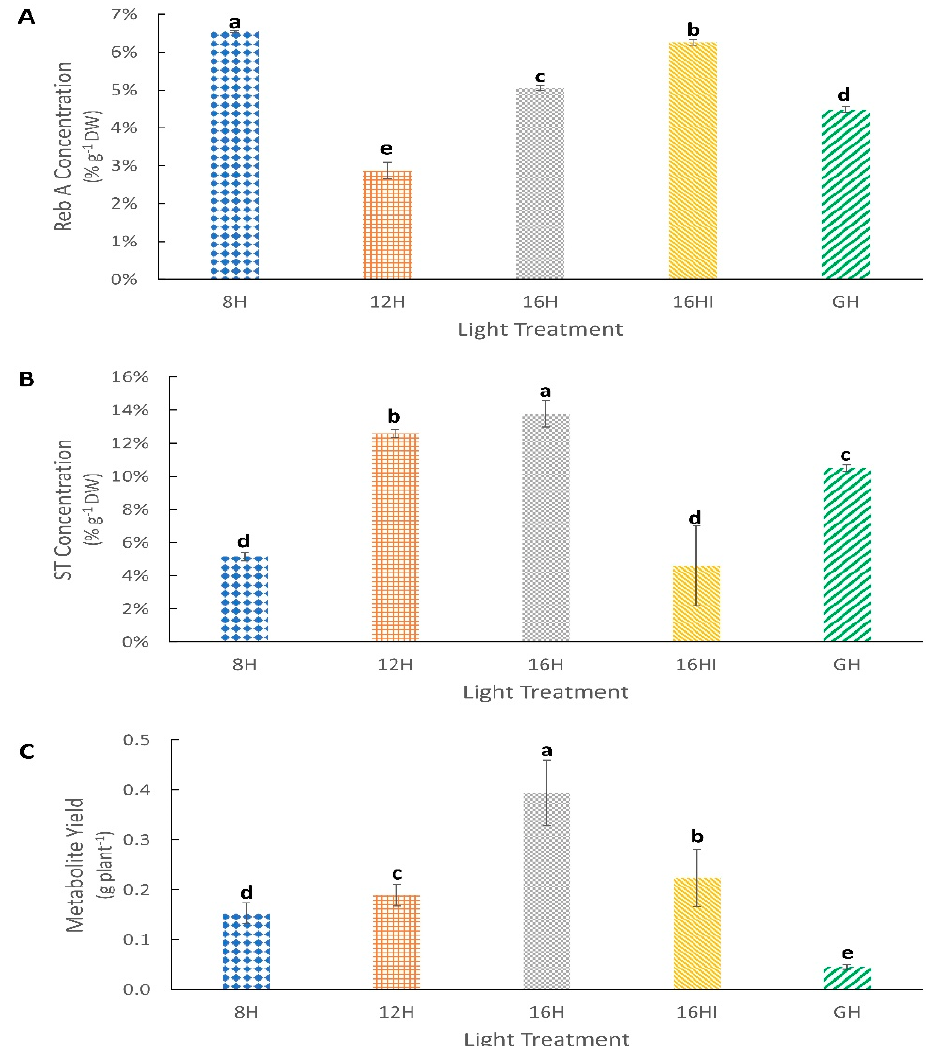
Figure 4. Effect of photoperiod on metabolite accumulation in Stevia rebaudiana leaves. ( A ) Percentage concentration of Reb A in dry leaf weight (%). ( B ) Mean percentage concentration of ST in dry leaf weight (%). ( C ) Average metabolite (ST + Reb A) yield per plant (g plant − 1 ). Values represents Mean (n = 72) ± Standard Deviation. Different letters above the error bars indicate statistical significance determined by Tukey’s HSD post hoc test at p < 0.05.